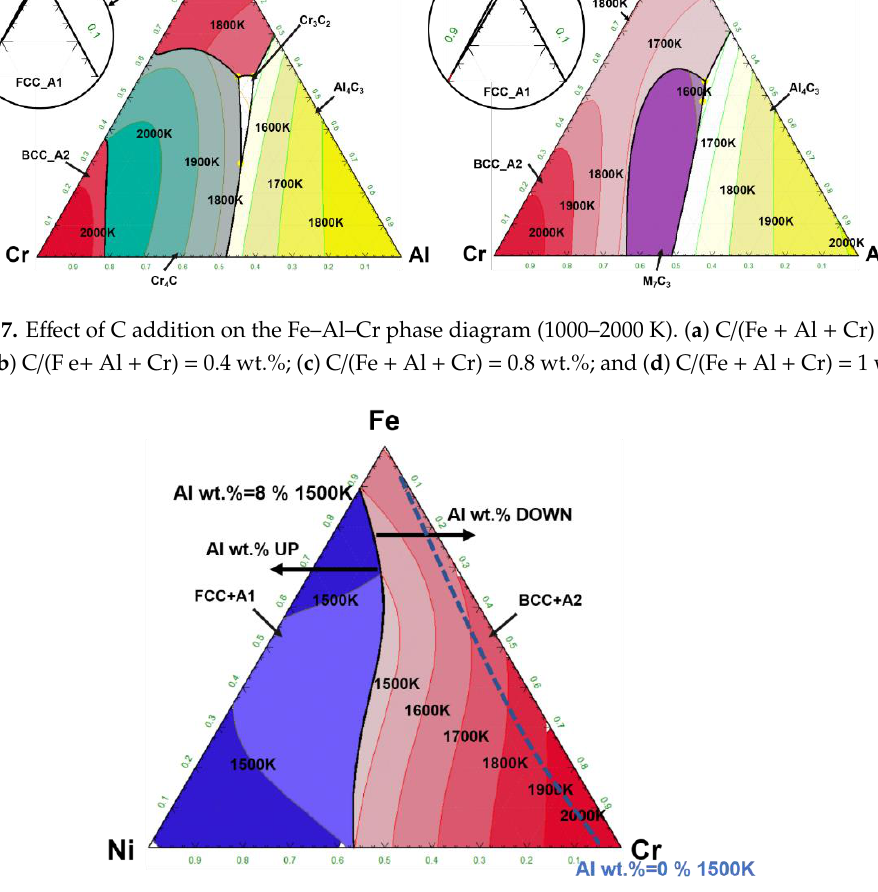
Figure 8. Effect of Al addition on the Fe – Ni – Cr phase diagram (1000 – 2000 K).